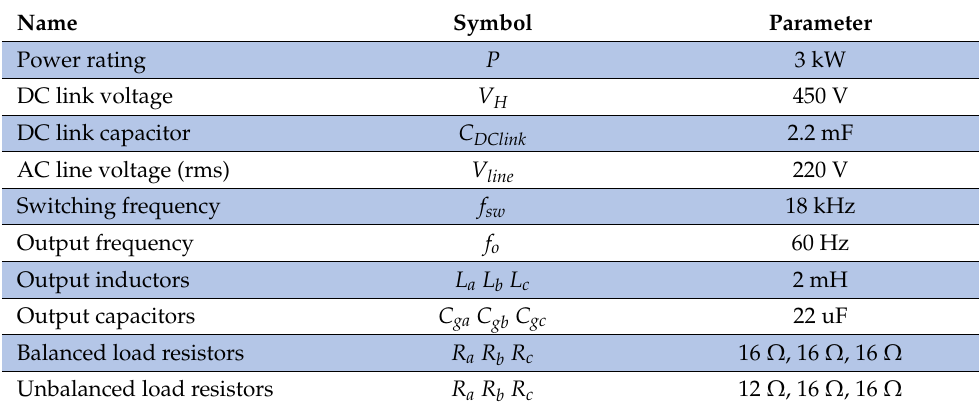
Table 1. Parameters of the full-scale voltage rating inverter used in simulation and experiment.